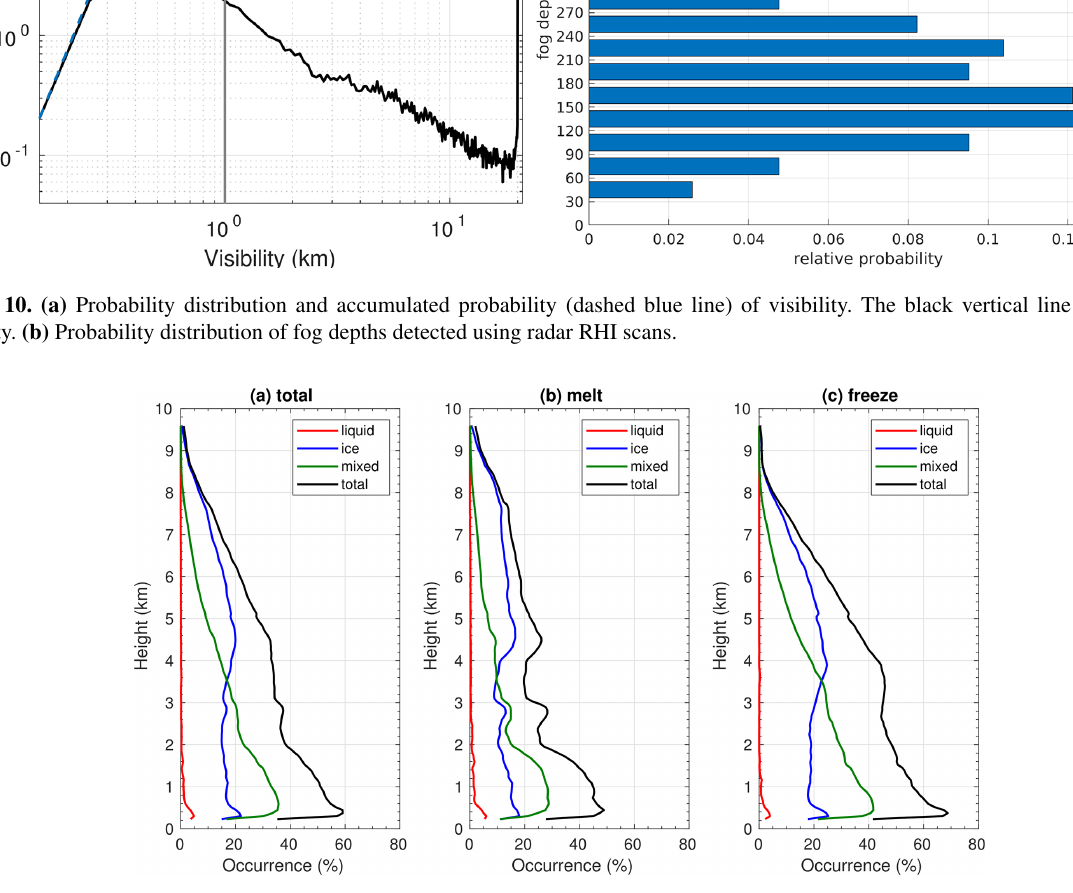
Figure 11. Mean cloud occurrence per volume for different cloud types, obtained from the Cloudnet target classification product: mean profiles (a) for all available Cloudnet data, (b) for the melt period, and (c) for the freeze